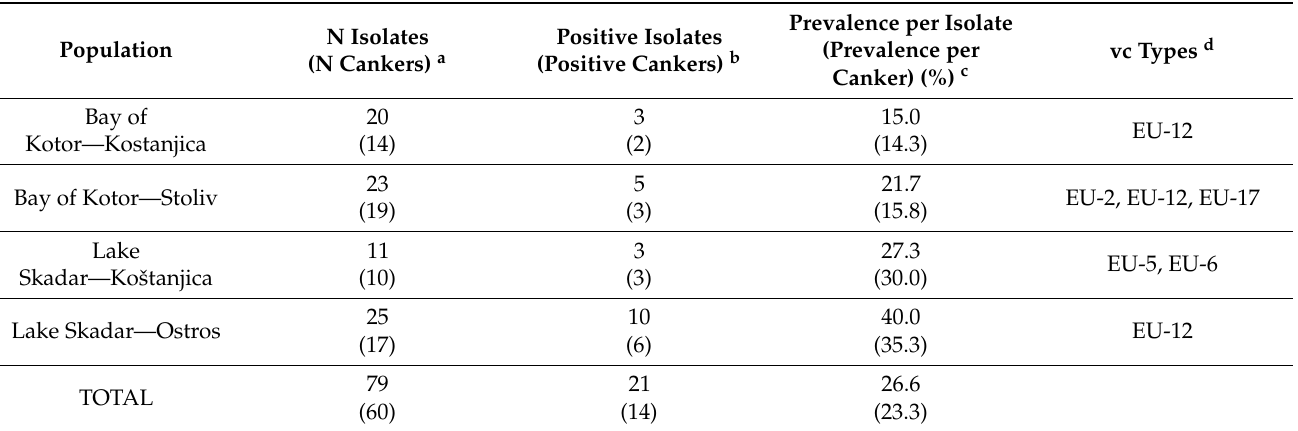
Table 4. Cryphonectria hypovirus 1 (CHV1) prevalence in Cryphonectria parasitica isolates from four populations in